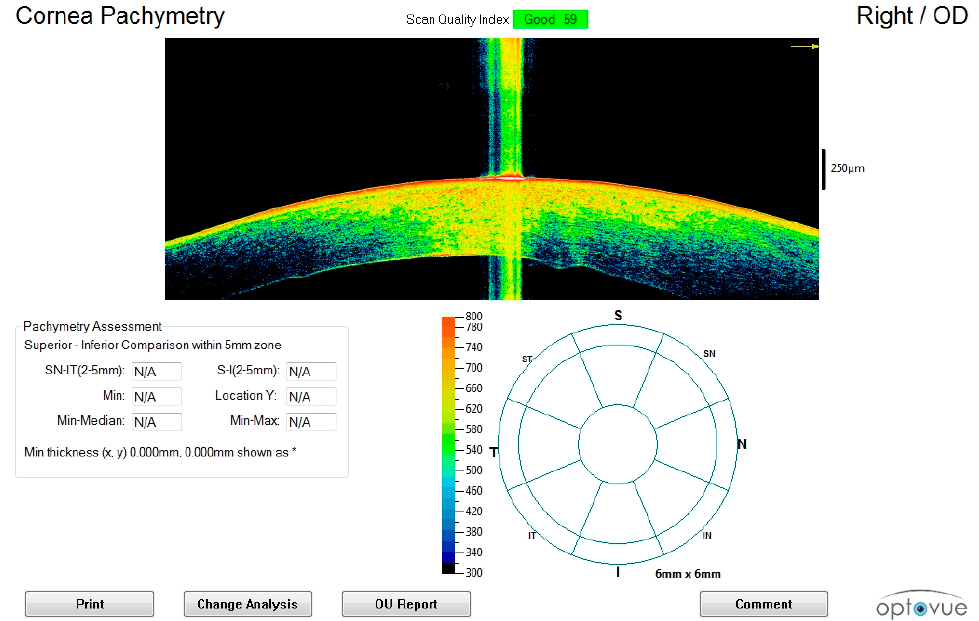
Figure 2. Corneal scan in the intermediate postmortem interval (twelvth hour) Enhancement of the thickening with differentiation between anterior (hyper-reflective) and posterior (hypo-reflective) segments of the stroma is observed.